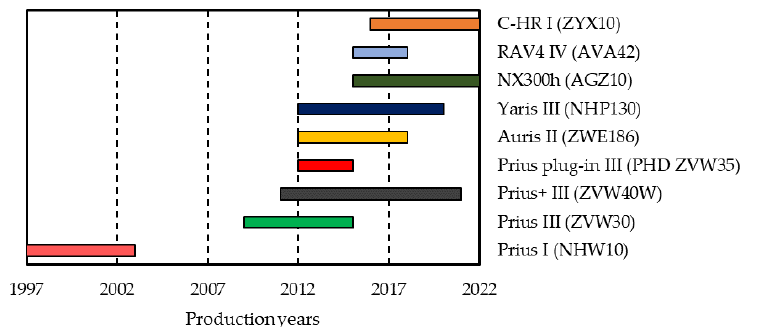
Figure 2. Range of production years for hybrid vehicle models used in the study [34,35].